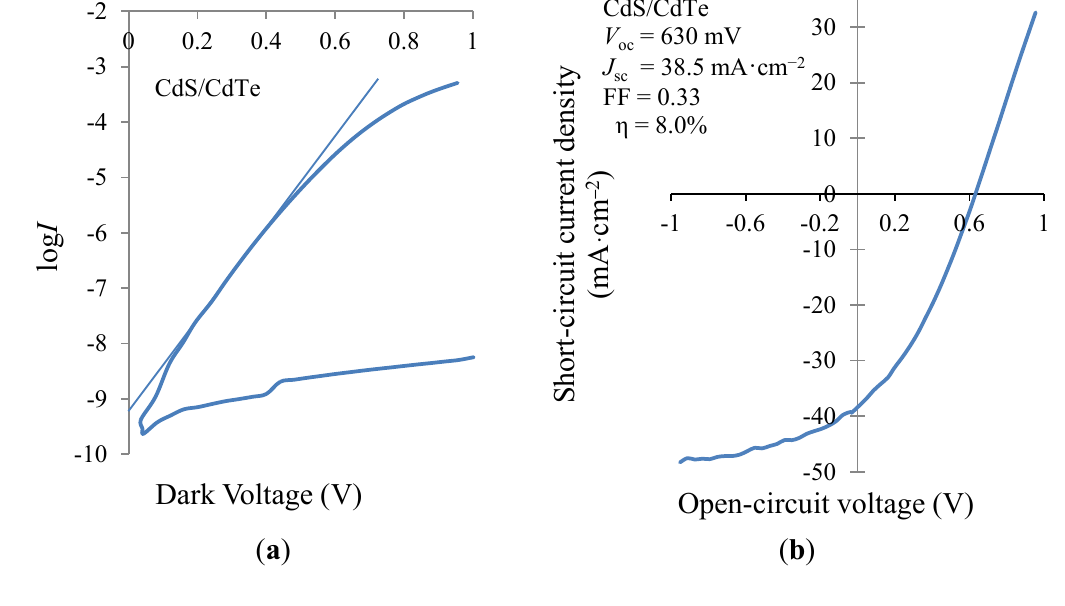
Figure 15. Current-voltage characteristics ( a ) under dark conditions using the log-linear scale and ( b ) under AM1.5 illumination using the linear-linear scale, for glass/FTO/CdS/ CdTe/Au solar cell